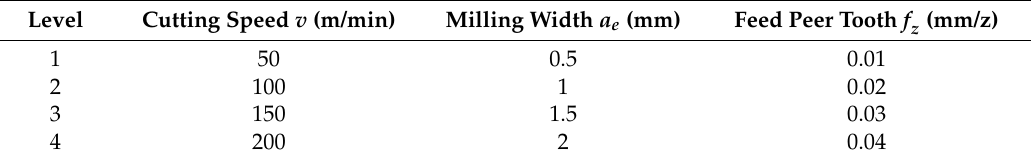
Table 4. Design of experiment.